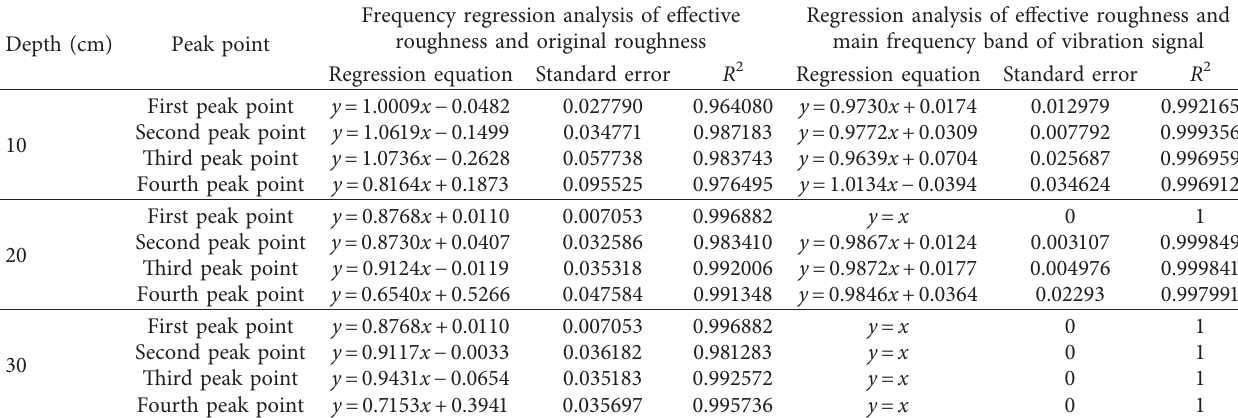
Table 4: Regression analysis of effective roughness peak point frequency and original roughness excitation point and vibration signal main frequency band peak point